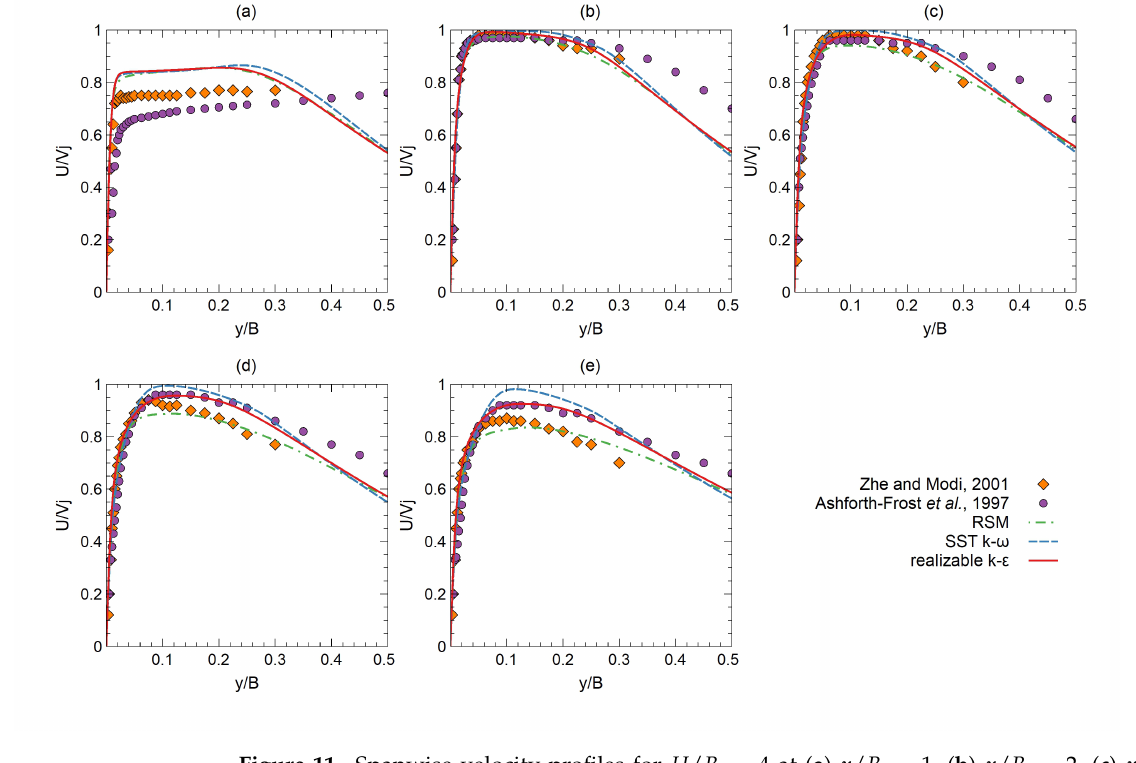
Figure 11. Spanwise velocity profiles for H / B = 4 at ( a ) x / B = 1, ( b ) x / B = 2, ( c ) x / B = 3, ( d ) x / B = 4, and ( e ) x / B = 5, compared to reference results reported by Ashforth-Frost et al. [15] and Zhe and Modi [14].